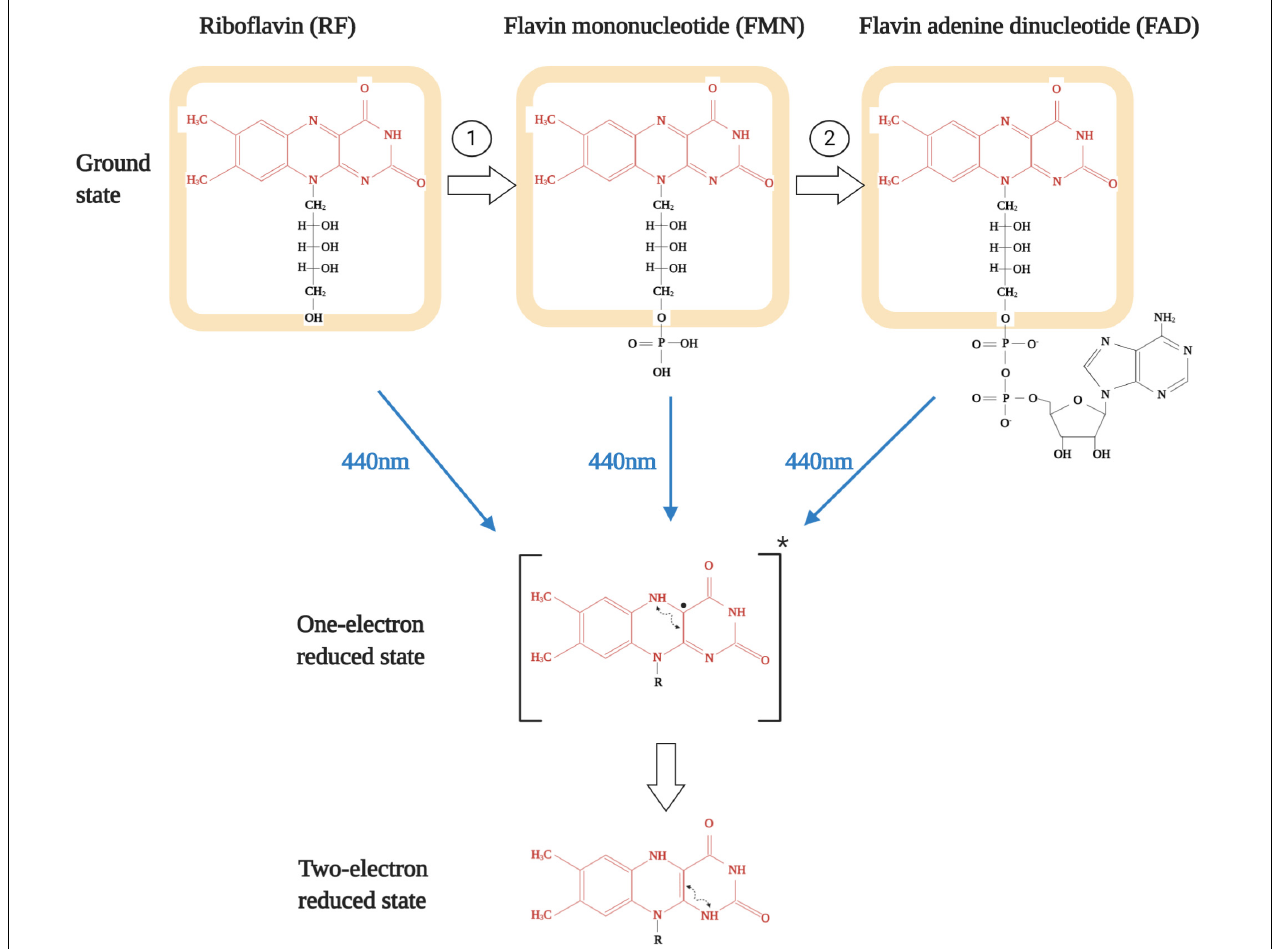
FIGURE 2 | Structures of various flavins and their subsequent excitation upon blue-light exposure. Isoalloxazine ring is shown in red while riboflavin structure is shown as highlighted in orange. Reaction 1 is catalyzed by riboflavin kinase and reaction 2 is catalyzed by FAD